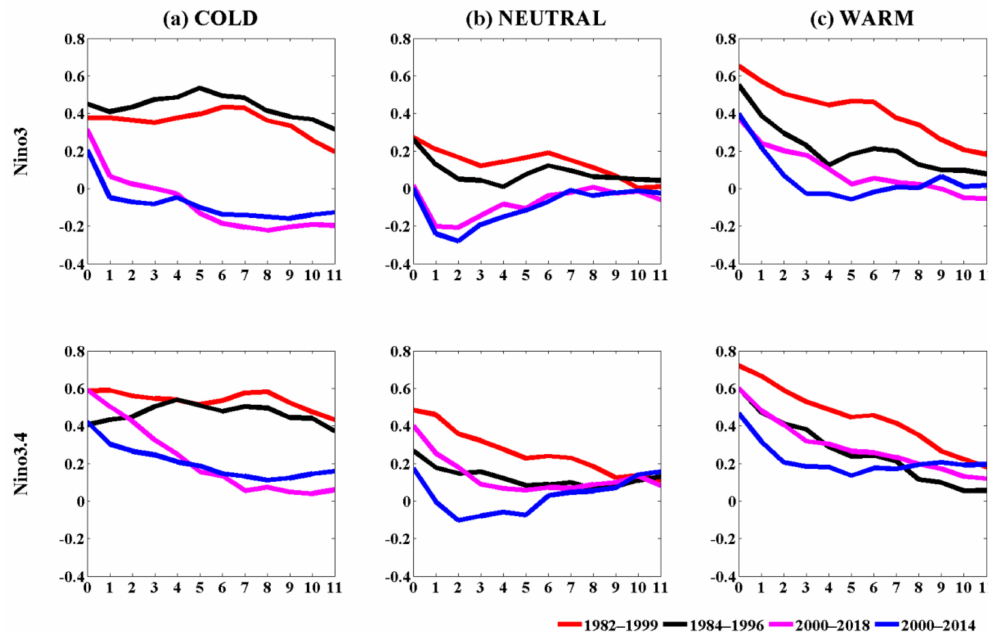
Figure 10. The BSS of the Niño3 and Niño3.4 indexes as a function of lead time for the COLD ( a ), NEUTRAL ( b ), and WARM ( c ) SSTA categories for the four